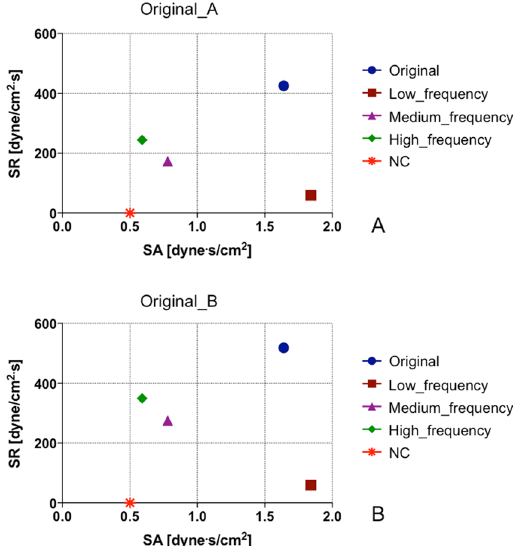
Figure 3. Values of SA and SR of each of the test-curves: by selecting specific frequency components of the spectrum of Original curves, we obtained a set of shear stress waveforms modulating the SA and SR values. ( A ): Original_A; ( B )